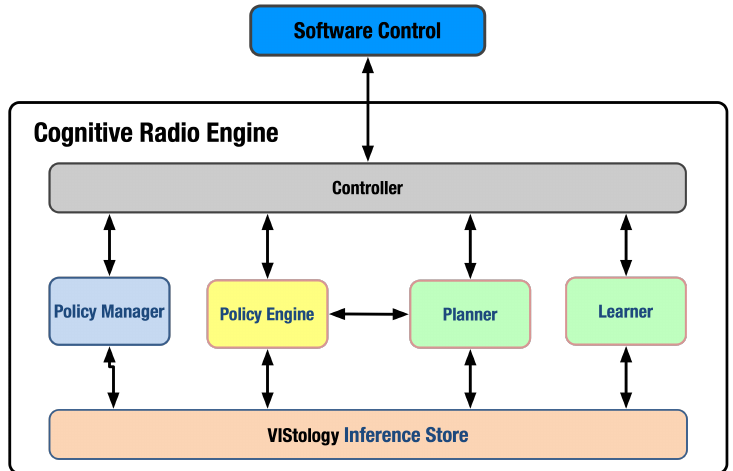
Figure 4. The Cognitive Radio Engine architecture described in this